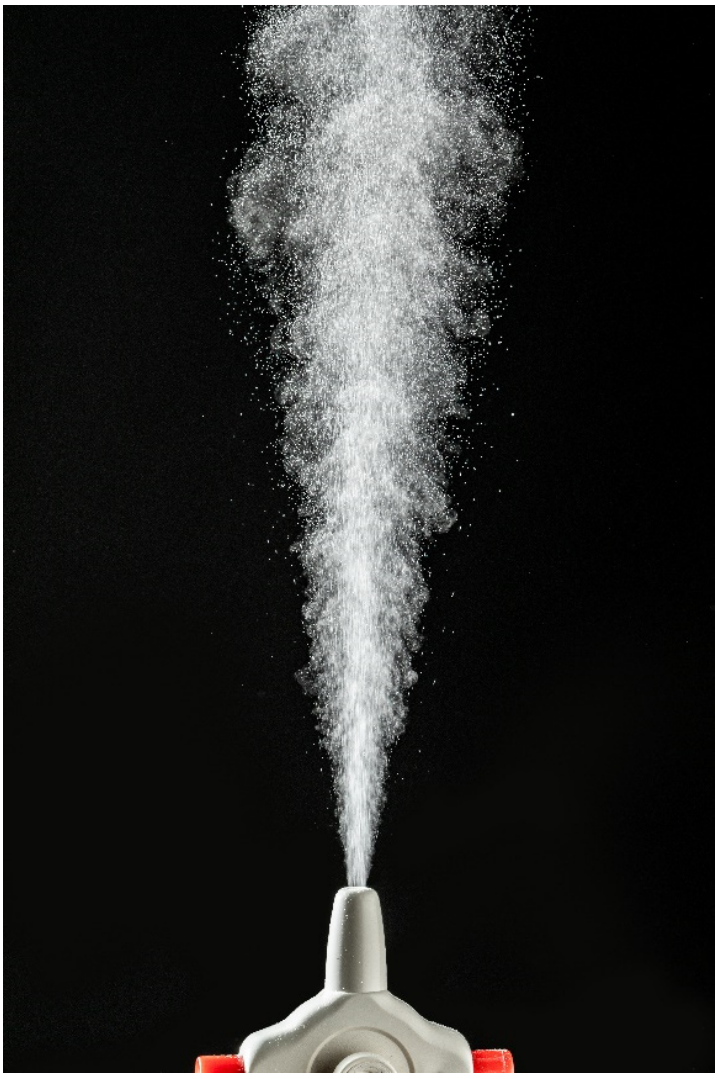
Figure 7. Spray cone of DSP-MS/Mannitol 1:9 upon aerosolisation with Miat ® insufflator.